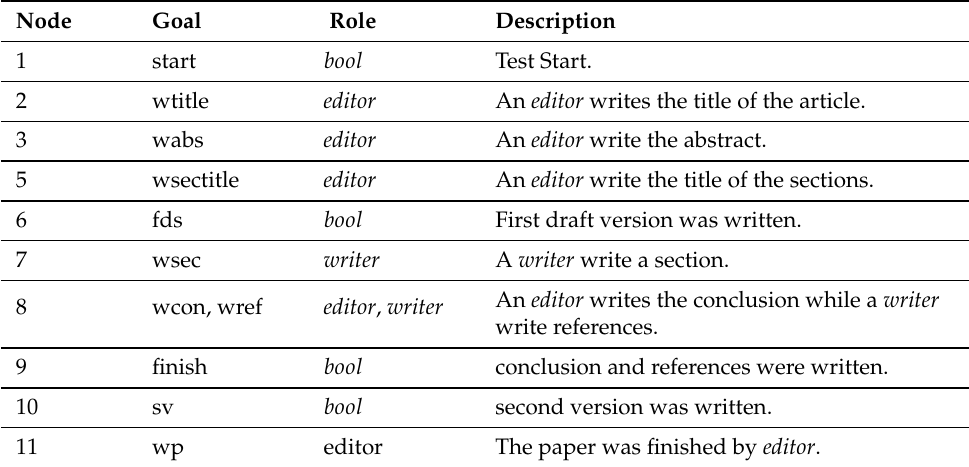
Table 5. Test case for Writing Paper with state transition path criterion.